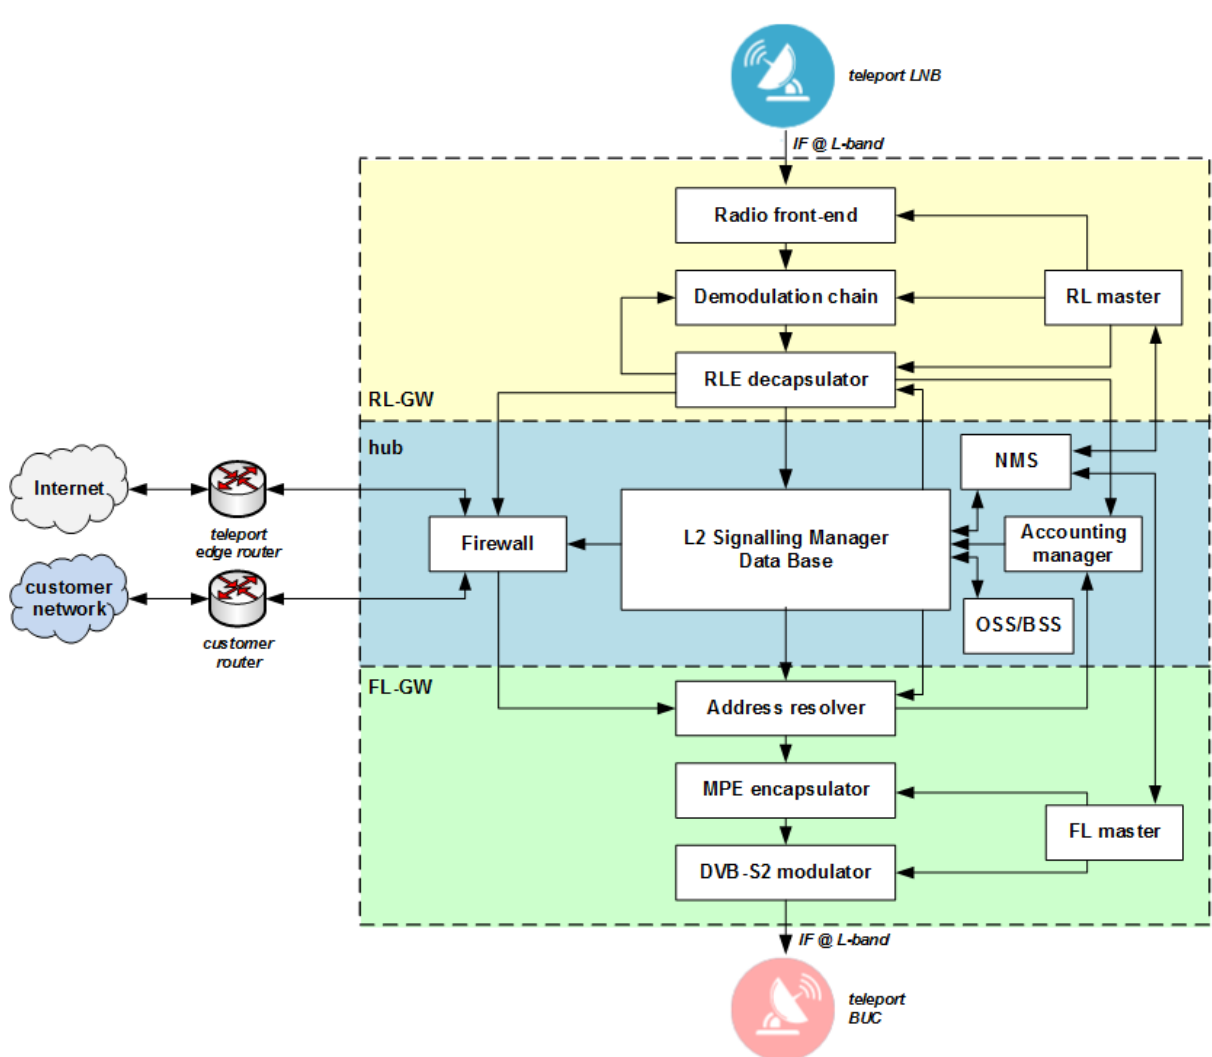
Figure 11. Detailed block diagram of the HyperCube platform.